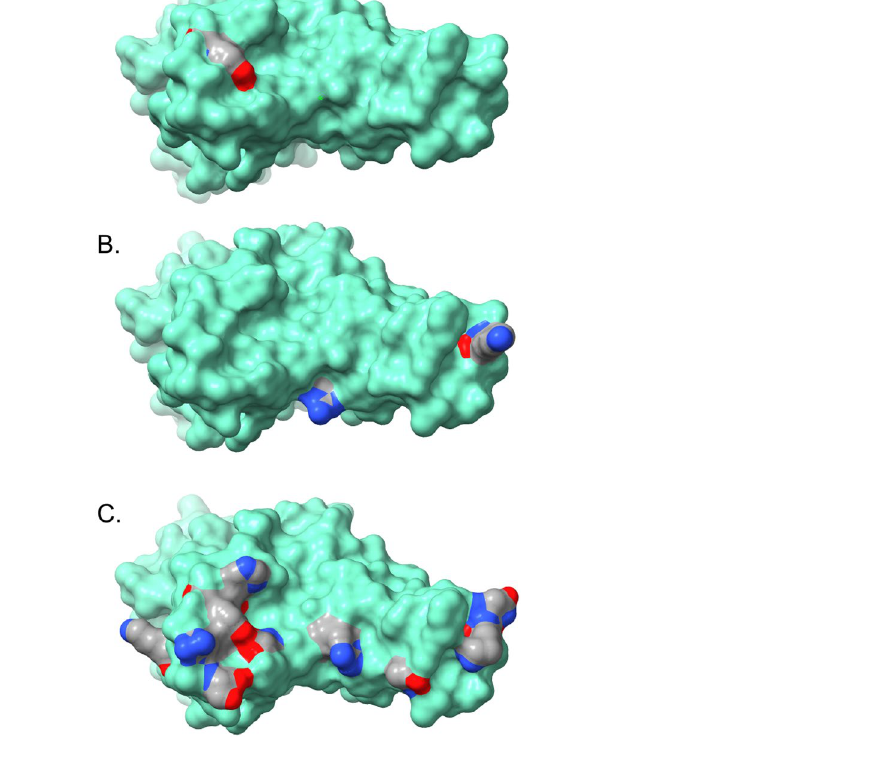
Figure 5. Receptor binding domain (RBD) contact surface observed in the angiotensin-converting enzyme 2 (ACE2) complex with the RBD (based on the crystal structure for the ACE2-RBD complex—PDB ID: 6M0J). Key RBD mutations that may impact ACE2 and/or antibody binding are color-coded by atom type (carbon— grey, nitrogen—blue, oxygen—red). ( A ) Alpha variant ( B ) Delta variant ( C ) Omicron